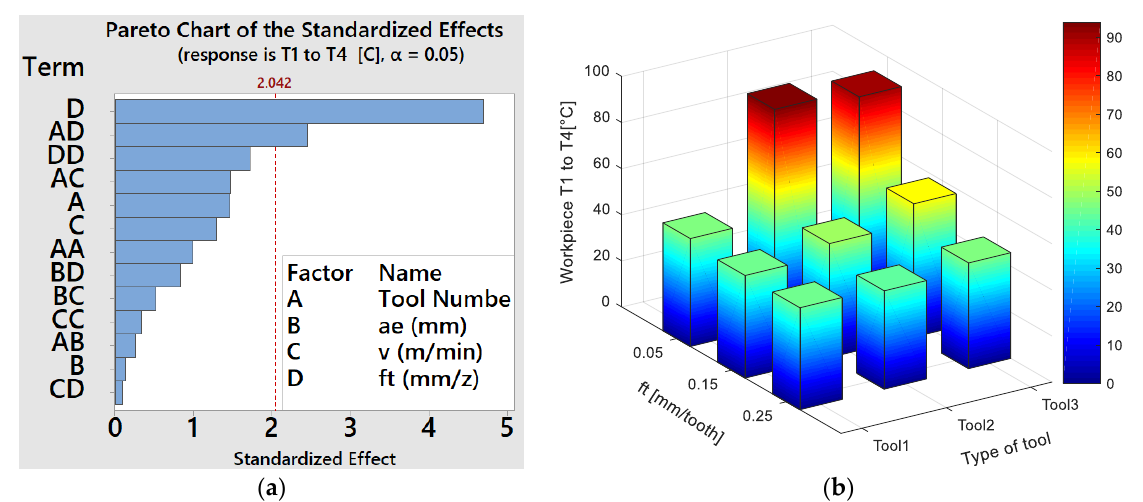
Figure 7. ( a ) Pareto chart of standardized effects on T1 to T4; ( b ) 3D bar effect graph for T1 to T4.